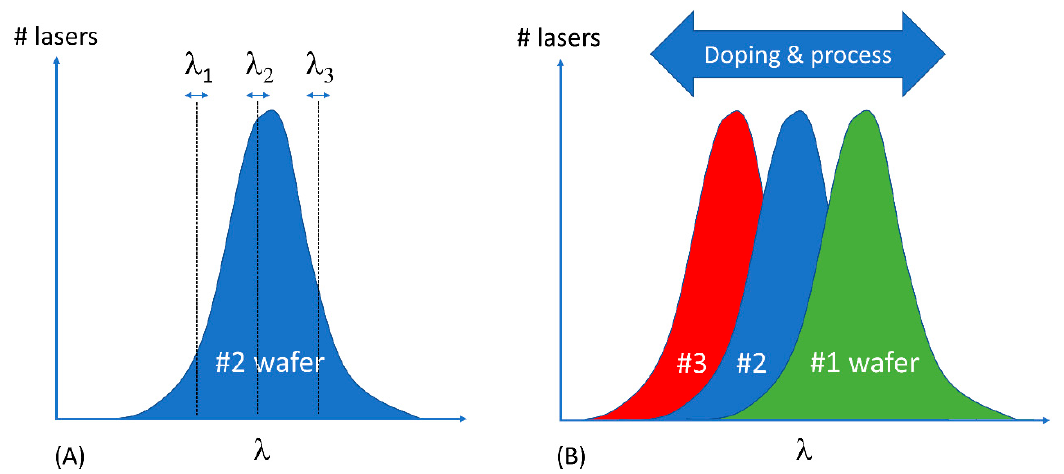
Figure 6. Representation of a generic statistical distribution of lasers over their initial wavelength ( λ ) in a set of three wafer runs. Different wafers may result in different central λ s. ( A ): distribution of initial λ of wafer #2; ( B ): example of an initial λ s distribution for three different wafers.